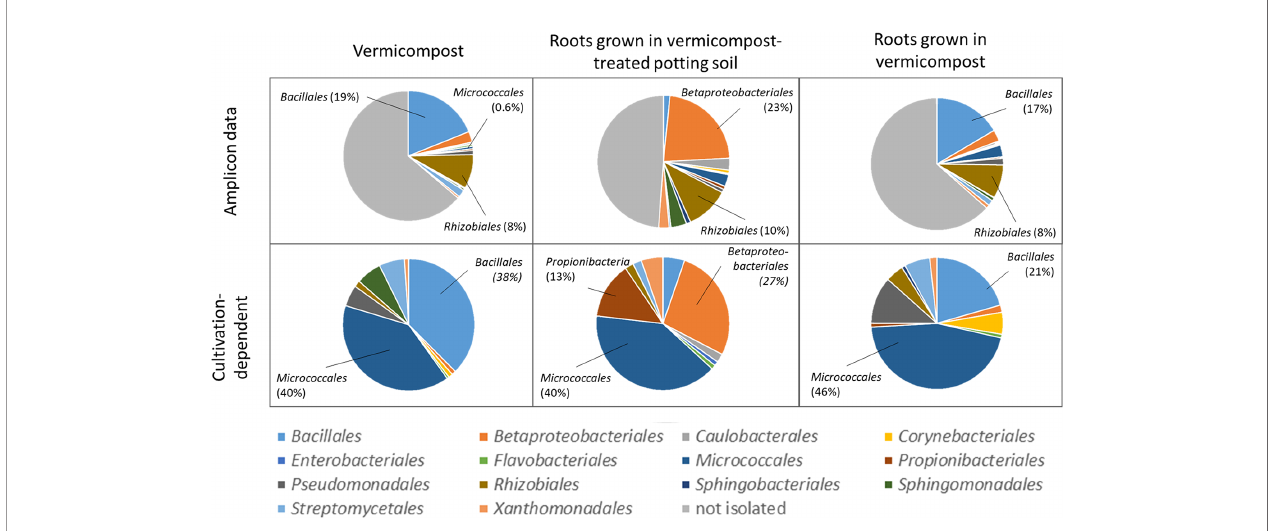
FIGURE 7 | Comparison of microbiome assessment using cultivation-dependent (isolation on R2A plates) and – independent (16SrRNA amplicon sequencing) approaches on order